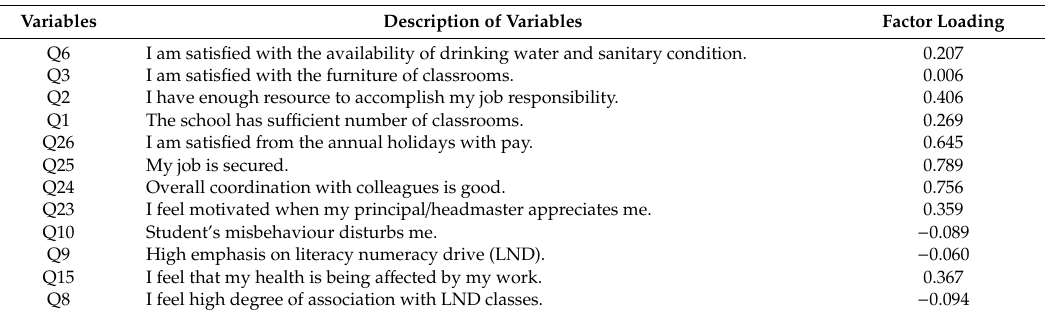
Table 9. Standardized direct effects of STRESS.